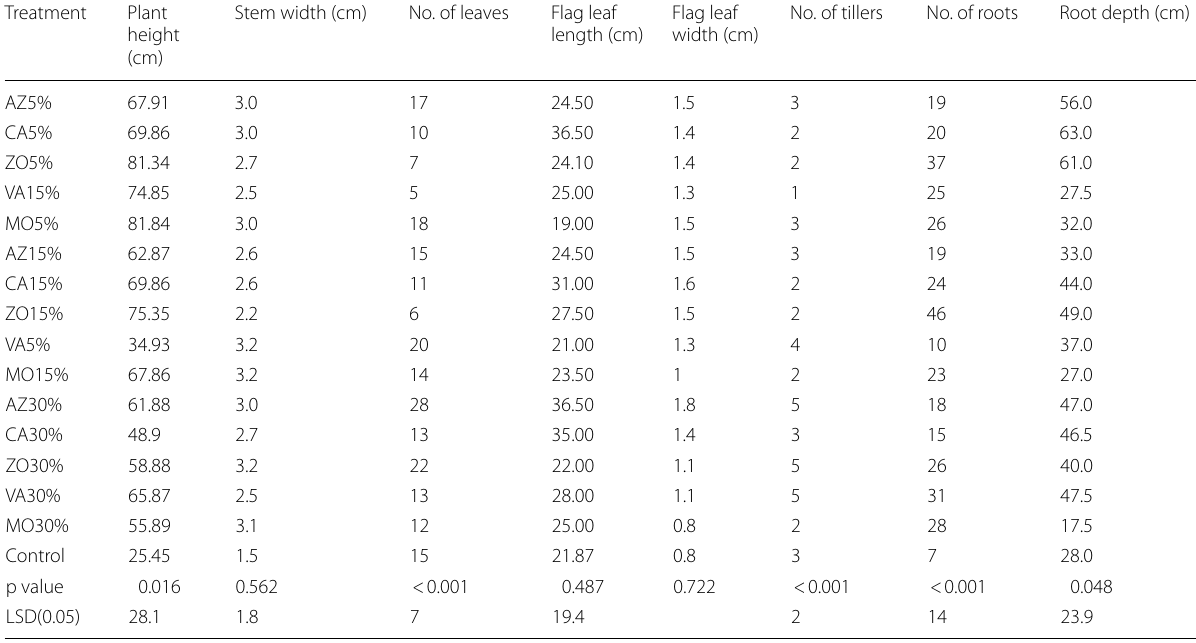
CA Carica papaya, VA Vernonia amygdalina, MO Moringa oleiofera , AZ Azadiracta indica ZO Hibiscus sabdariffa Table 3 The effects of nanoparticles on growth parameters of rice plants exposed to nanoparticles and sown in ferruginous (F) and non-ferruginous (N) soils at 12 weeks after sowing (8 weeks after nano-intervention)